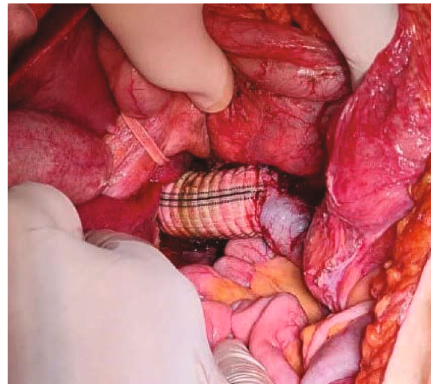
Figure 4: Intraoperative image showing the implanted IVC Dacron graft at the level of the left renal